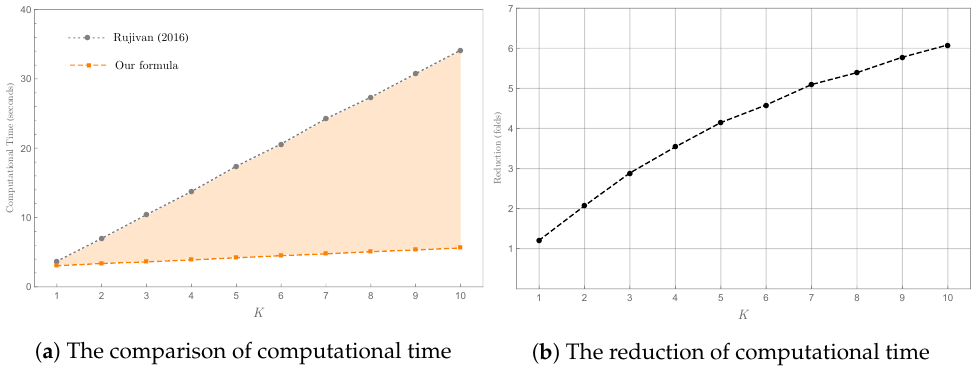
Figure 12. The efficiency of our explicit Formula (38) over the explicit formula written in Equation (2.2) of Rujivan [12] for calculating U